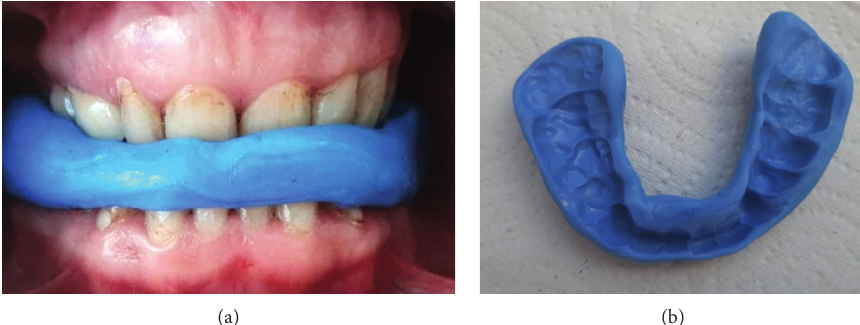
Figure 7: (a, b) Stabilization of the mandibular head position in the center using a temporary silicone occlusal splint (CyberTech silicone putty; DE Healthcare Products Gillingham ME8 OSB U.K.).